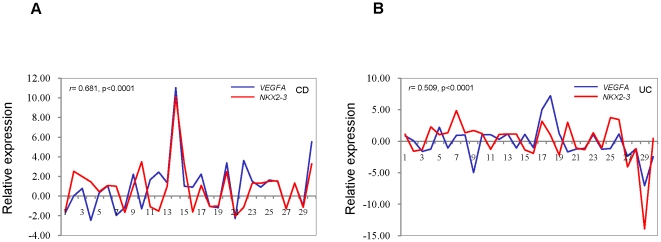
The correlation between the expression levels of NKX2-3 and VEGFA in intestinal tissues from IBD patients.(A) The correlation between the expression levels of NKX2-3 and VEGFA in diseased and adjacent normal intestinal tissues from 30 CD patients. RT-PCR was carried out on surgically excised intestinal tissues. The RT-PCR product bands on the photograph were scanned by densitometry. RT-PCR results were normalized by GAPDH for each sample. Fold change results of normalized NKX2-3 or VEGFA were summarized as a ratio of medians (CD: adjacent normal tissue) in every patient. Correlation coefficient (r) and p value are shown. (B) The correlation between the expression levels of NKX2-3 and VEGFA in diseased and adjacent normal intestinal tissues from 30 UC patients.